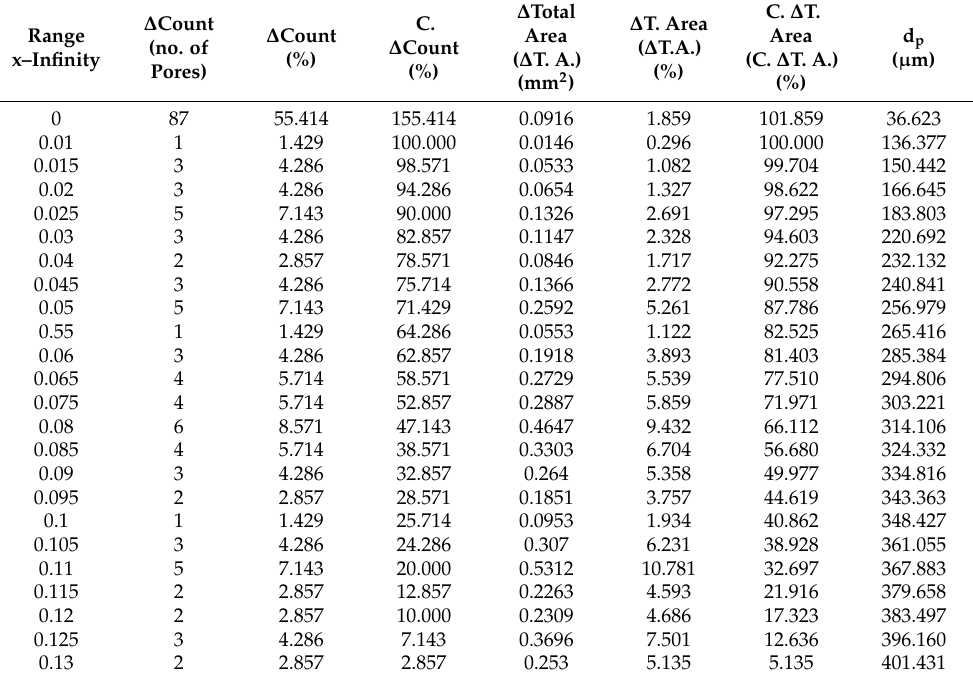
Table A3. Calculation of porosity parameters based on measurements in Table